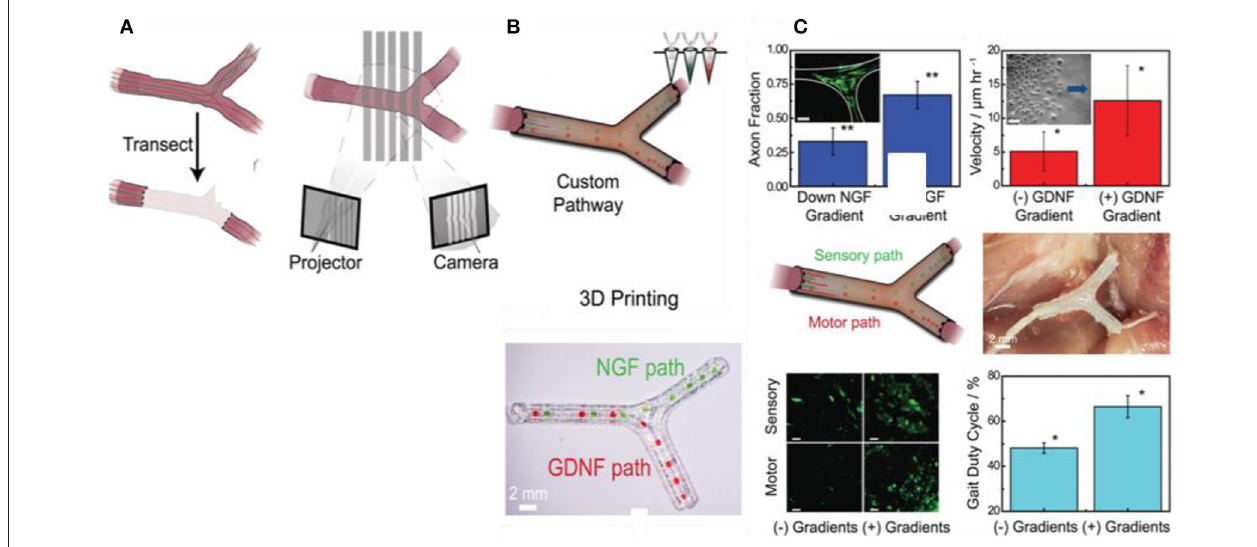
FIGURE 8 | Guided neurite extension in 3D printed scaffold; (A) Nerve regeneration pathways enabled by 3D scanning and printing, (B) The 3D printing process provided the ability to introduce advantageous physical and biochemical cues in the form of microgrooves and multicomponent diffusive biomolecular gradients, (C) In vitro and in vivo characterization of regeneration with 3D printed nerve pathways (Johnson et al., 2015), Copyright 2015, John Wiley and